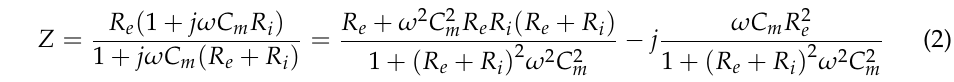
Figure 1. Conductive pathways of high-frequency and low-frequency currents in biological tissues